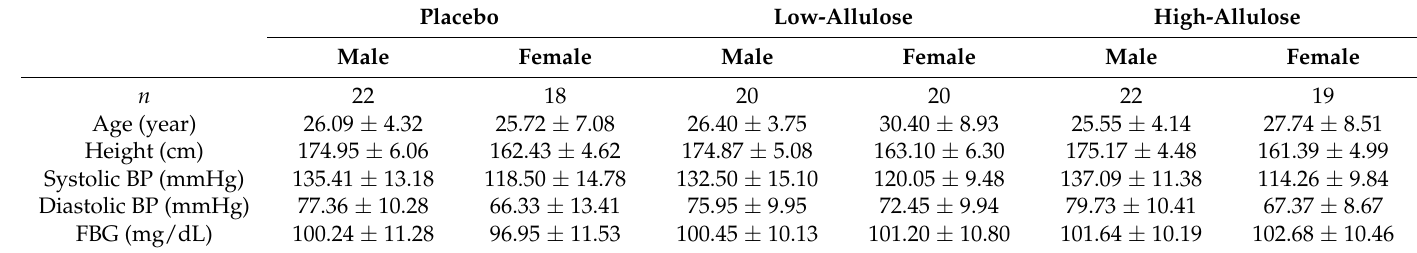
Table 3. Physical activity measurement and nutrient intake in the three groups of overweight or obese subjects based on 24-h dietary recall during the study. Placebo (M:17, F:23) Low-Allulose (M:20, F:20) High-Allulose (M:22, F:19) Baseline Follow Up Baseline Follow Up Baseline Follow Up Physical activity 1 2.13 ± 0.10